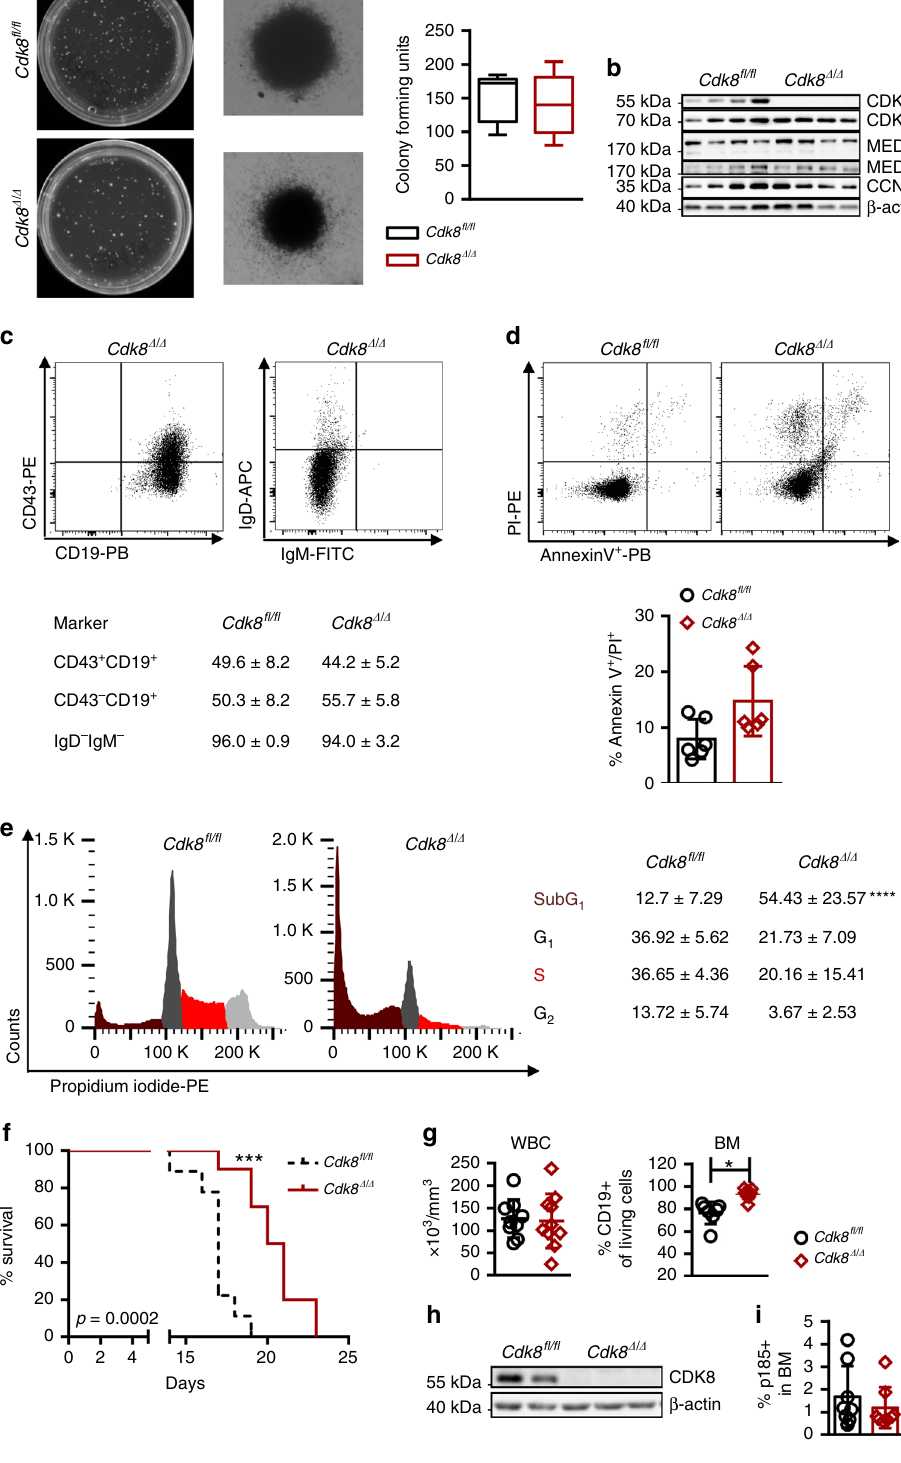
A complete list of deregulated pathways is provided in Supple- mentary Table 1. Con fi rmation was provided by the EnrichR program (Supplementary Fig. 6a and Supplementary Table 2), which validated the deregulation of 18 genes (Supplementary Fig. 6b). Phosphorylation of key players in the mTOR pathway (pS6 S240/244 , p4E-BP-1 T37/46 , and pAKT S473 ) was reduced